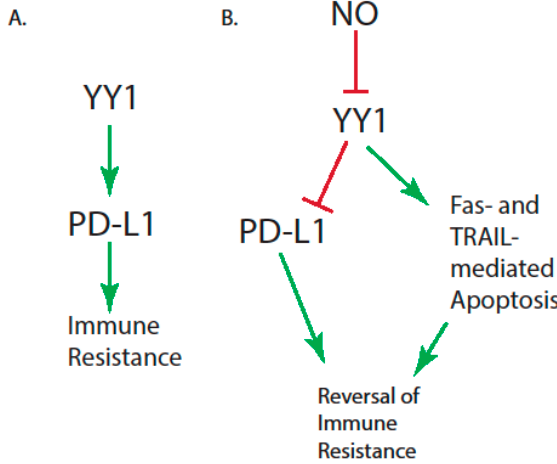
Figure 1. NO, YY1, and PD-L1 in the reversal of immune resistance. ( A ) YY1 mediates the expression of PD-L1 in tumor cells, leading to CTL-mediated immune resistance. ( B ) NO inhibits the activity of YY1, leading to, on the one hand, the inhibition of PD-L1 expression and DR5 expression and, on the other hand, the upregulation of Fas. Both of these effects of NO sensitize tumor cells to CTL-mediated cytotoxicity and tumor regression.